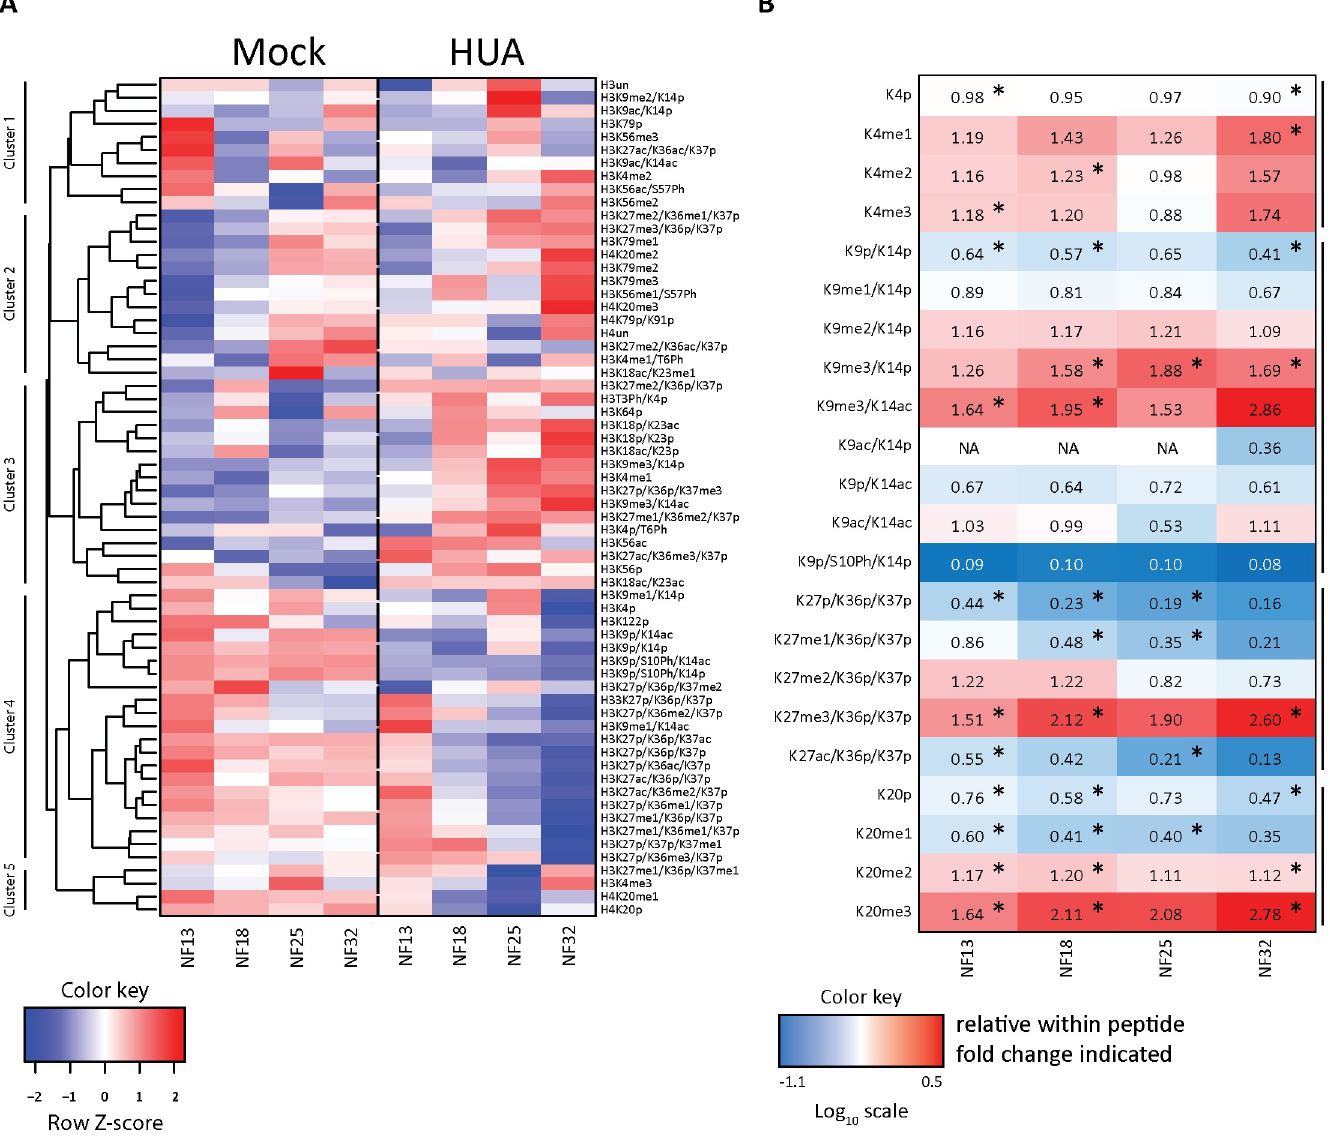
Fig 4. Mitotic activity shapes stage-specific HMPs. (A) Heatmap of the absolute histone modification states abundance, normalized to the corresponding R10 spiketides. Data in columns represent an average from 3 biological replicates/condition. Color key: row Z-score. The individual quantitative observations can be found in S2 Data. (B) Ratio heatmap of relative histone modifications abundance for selected histone marks. In the first step, relative distributions of the indicated modification states were calculated in percentages within each tryptic peptide (see S4 Fig). Then, HUA values were divided by Mock values to produce the relative change for each histone modification state between the 2 conditions. Color key is based on the Log10 scale. Numerical values in the cells indicate the fold-change. Values greater than 1.0 indicate an increase in HUA condition; values smaller than 1.0 indicate a higher abundance in Mock condition. NA, not applicable, when values in Mock were 0. Asterisks ( � ), adj. p < 0.1 (Benjamini–Hochberg procedure). “p,” propionylated (naturally unmodified); “un,” tryptic peptide, which has no modification state. The direct comparison of relative histone PTMs abundance is shown in S4 Fig, with p -values indicated in S5 Table. HMP, histone modification profile; HUA, hydroxyurea and aphidicolin; PTM, posttranslational modification of